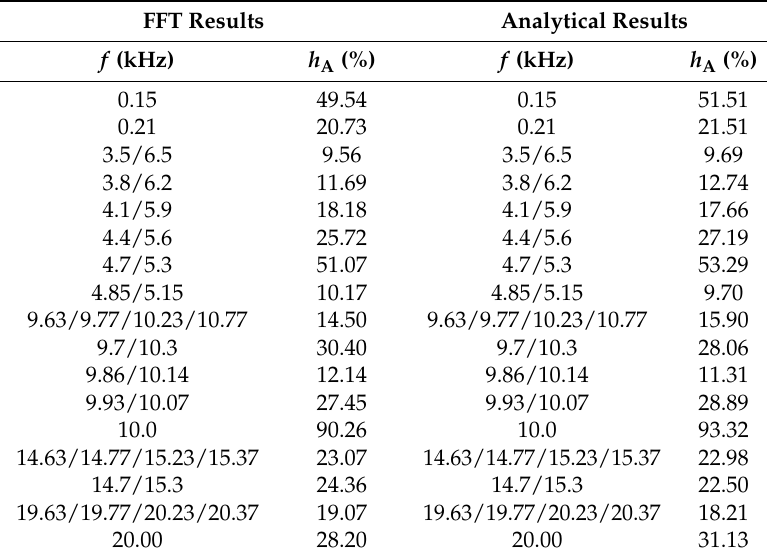
Figure 8. Time domain waveforms of output voltage and their FFT results ( a ) u A and its FFT ( b ) u AB and its FFT. Table 6. The main harmonic components in Figure 8.